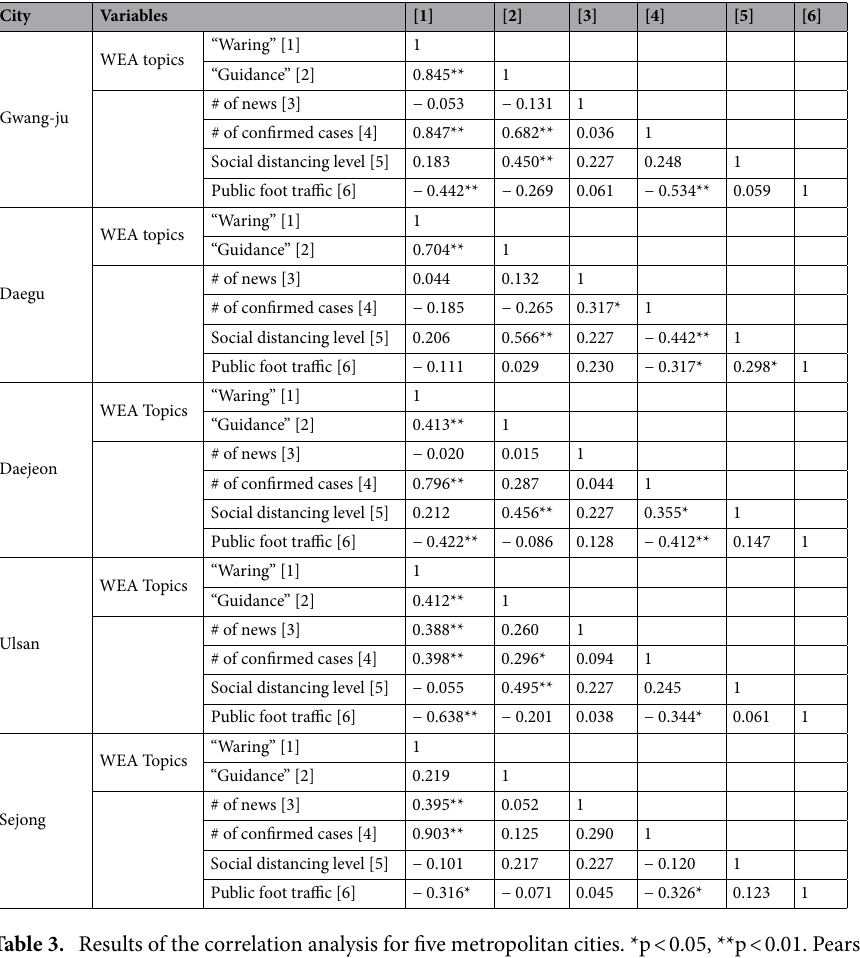
Table 3. Results of the correlation analysis for five metropolitan cities. *p < 0.05, **p < 0.01. Pearson correlation coefficient, N = 45.